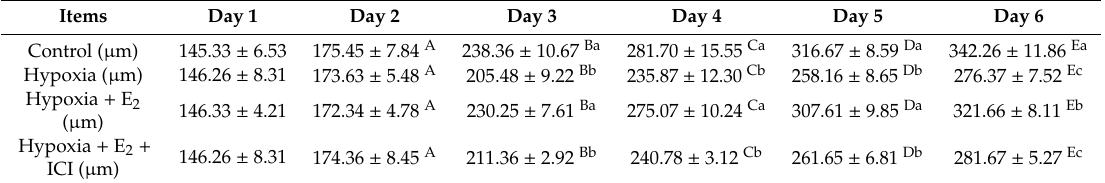
Table 2. The e ff ects of hypoxia on follicular diameter in